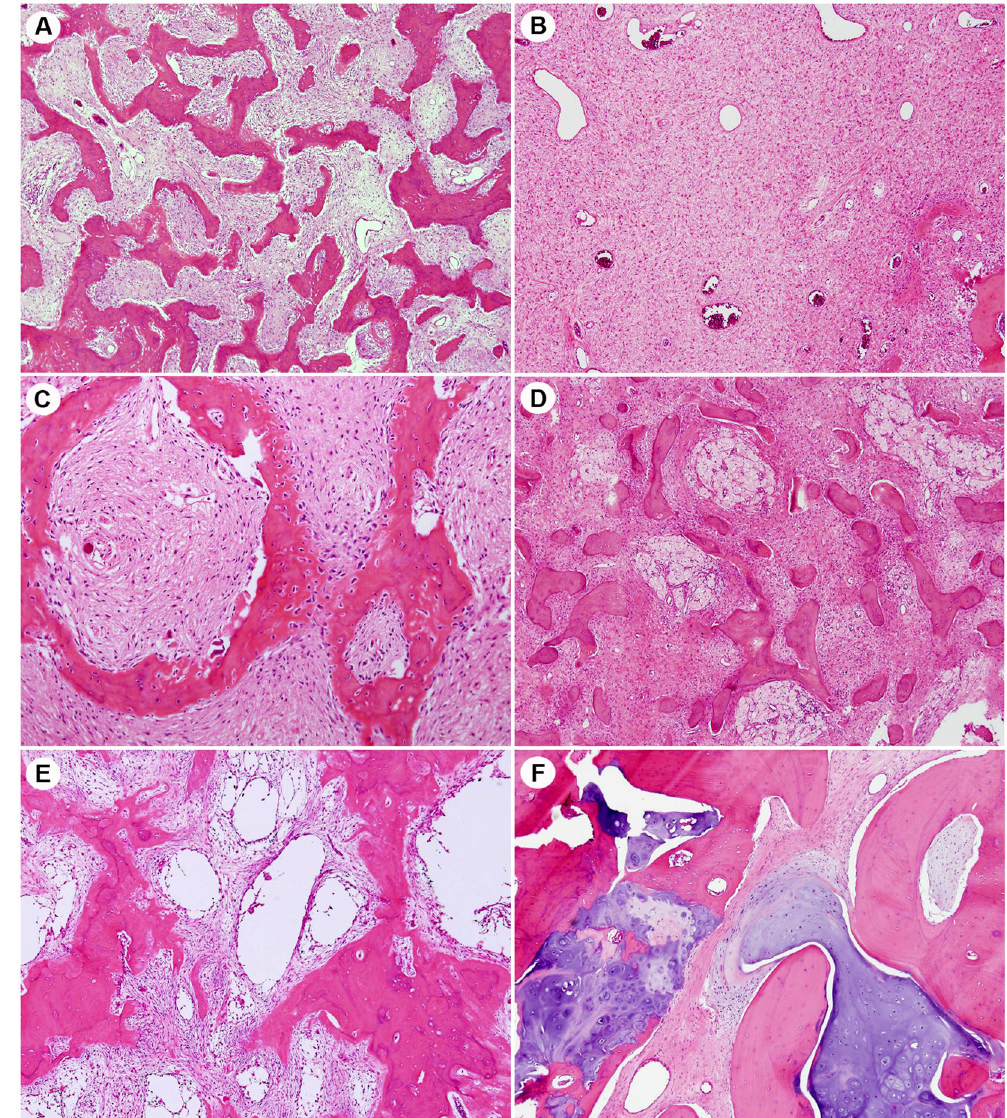
Figure 1. Histological features of fibrous dysplasia, which contains fibrous tissue with irregular, curvilinear, and trabeculae of woven bone in varying proportions. ( A ) Low fibrous tissue. ( B ) Abundant fibrous tissue. ( C ) Typical irregularly shape woven bones without osteoblastic rimming were observed in most cases. Some cases showed ( D ) aggregation of foamy histiocytes and ( E ) cystic changes. ( F ) Benign cartilaginous differentiation was observed in one